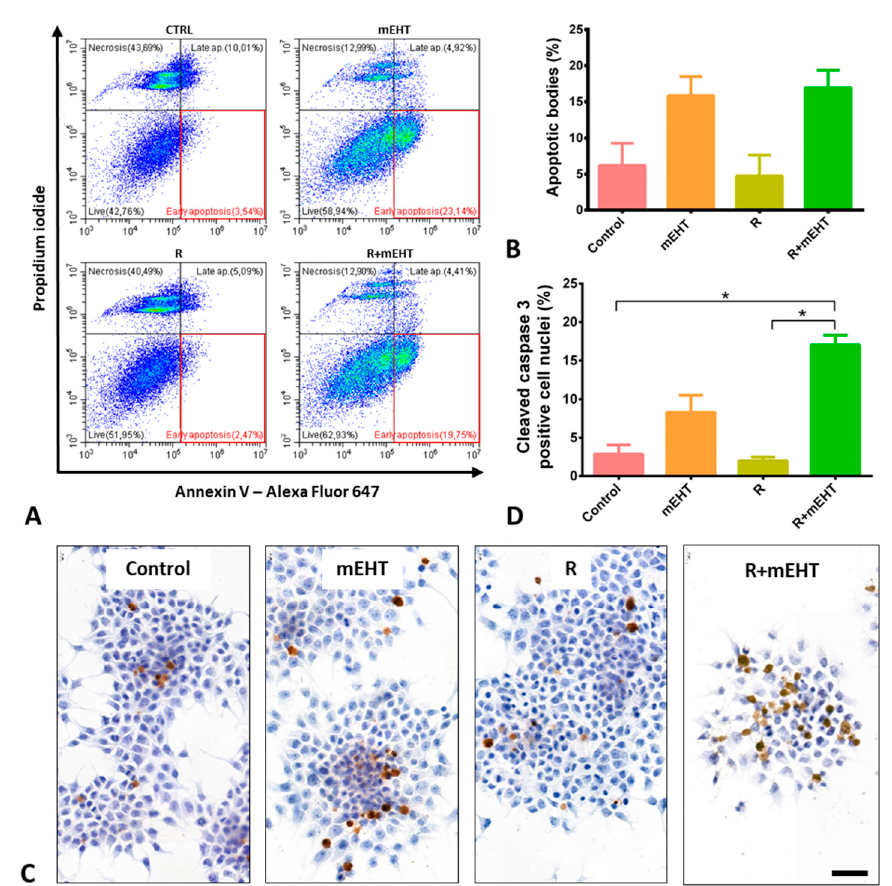
Figure 2. Apoptosis dominated programmed cell death induced by 60 min mEHT in Panc1 cultures. Representative flow cytometry results of Annexin V and propidium iodide double stained tumor cells 24 h after treatments. Red frames highlight early apoptotic cells ( A ). Graphical representation of early apoptotic bodies in proportions of the whole population. The Kruskal–Wallis test reveals a significant di ff erence among the 4 groups: p = 0.0084 TER = 0.28 ( B ). Cleaved / activated caspase-3 immunoreactions ( C ) quantified as detailed in Figure 6 (scale bar = 50 µ m) and graphical representation of its results. Kruskal–Wallis test shows a strong significance between the 4 groups: p = 0.0002. The Dunn’s test showed significantly elevated positivity in the R + mEHT group compared to R ( p = 0.028) and